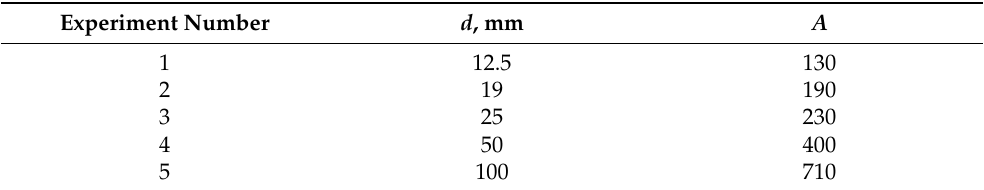
Figure 3. Deviation of the resistance curve from curve 2 for the turbulent regime into regions equidistant to curve 1 with the resistance law λ = 64/ Re , corresponding to the laminar flow regime. Table 3. The values of the “ A ” coefficient depending on the pipe diameter for a WSR-301 polymer solution concentration C = 15 × 10 − 6 according to Figure